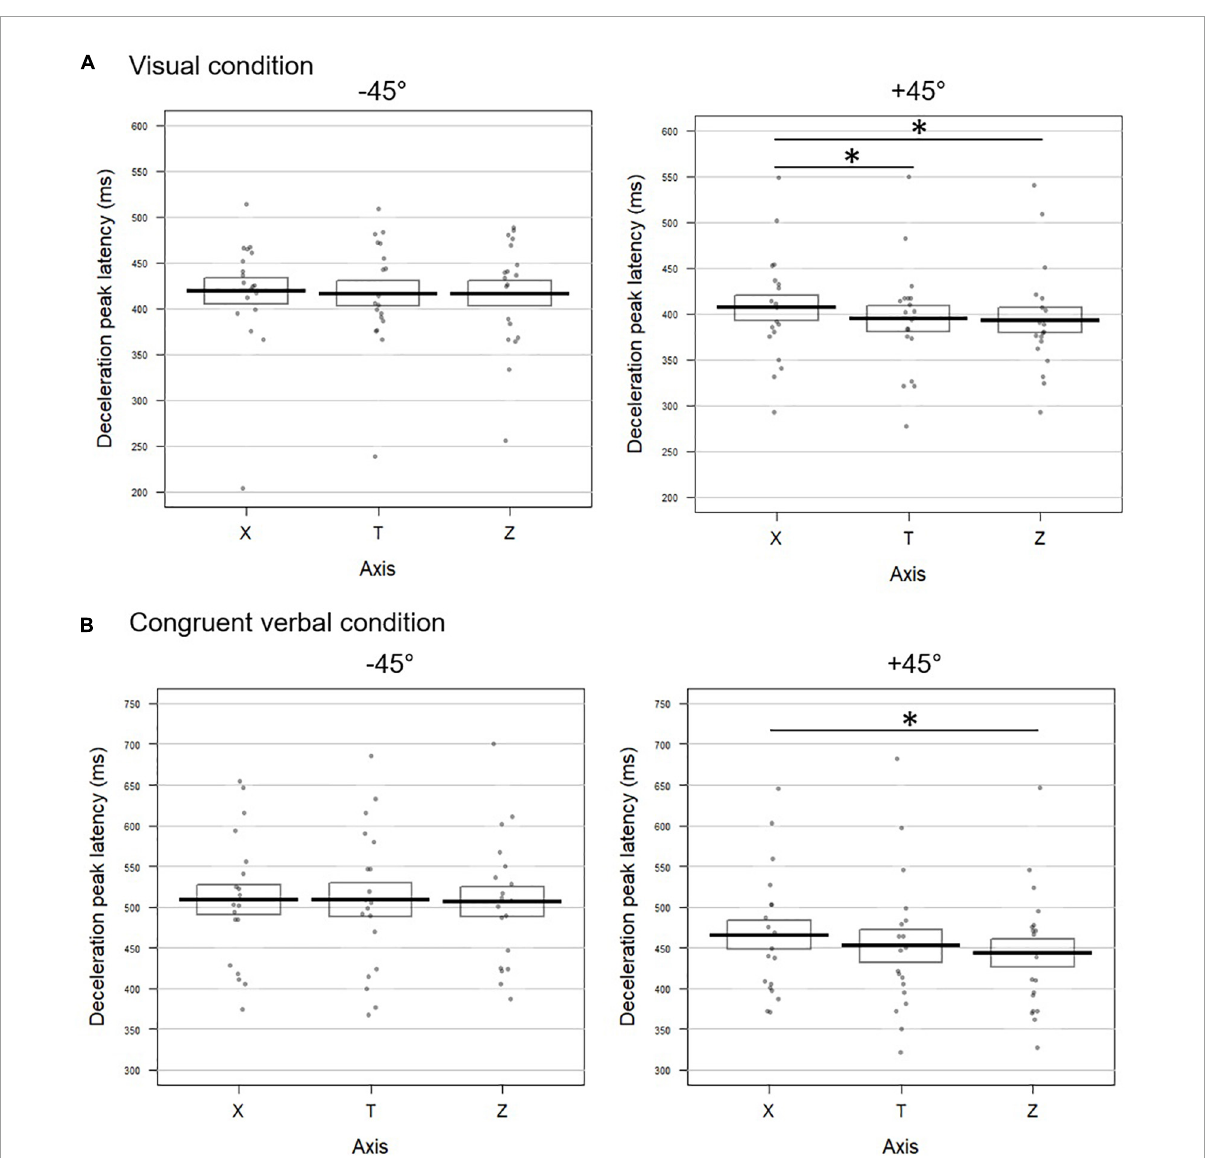
FIGURE6 Temporal dynamic of the movements toward –45 ◦ (left panel) and +45 ◦ (right panel) targets upon (A) visual and (B) congruent verbal instructions in Experiment 2. Latencies (in milliseconds) of the deceleration peak along the horizontal (X), tangential (T), and vertical (Z) axes are reported (see Figure 3 for conventions; ∗ indicates a significant difference between conditions). (A) In the visual block, pointing toward +45 ◦ targets resulted in later deceleration on X than on T ( t = 2.29; p = 0.038) and on Z ( t = –2.68; p = 0.016). (B) For +45 ◦ targets upon verbally congruent instructions, the deceleration peak occurred earlier on Z than on X ( t = –4.18; p = 0.0008).